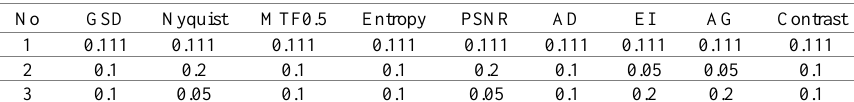
Table 4. The weight set of experiment B